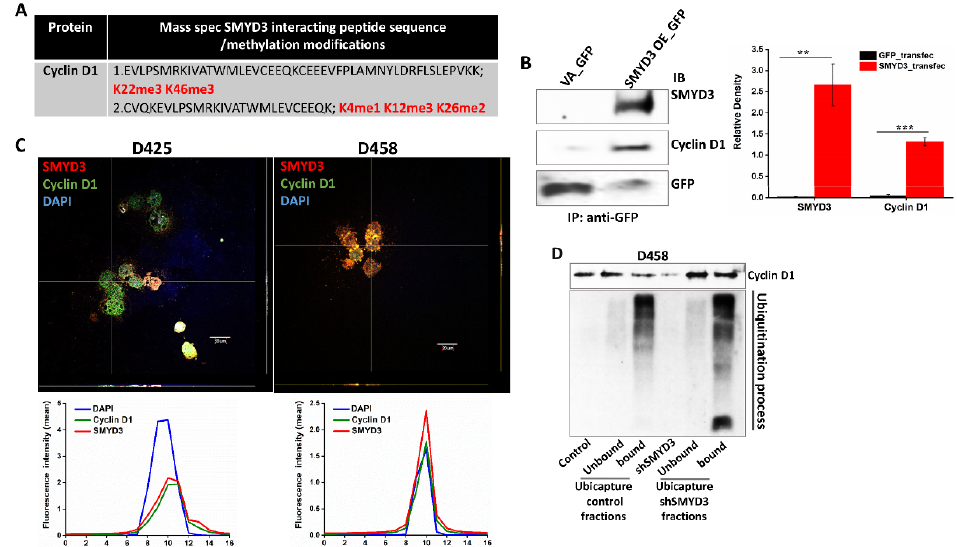
Figure 7. SMYD3-cyclin D1 interaction is associated with cyclin D1 stability in the nucleus. ( A ) LC/MS/MS analysis was performed using anti-SMYD3 antibody precipitated nuclear extracts of D283 cells. The mass spec analysis identified cyclin D1 peptide sequences and their lysine methylation modification sites. ( B ) D425 cell lysates (400 µg) from the GFP and GFP-tagged SMYD3 overexpressing cells were bound to the GFP-Trap ® Agarose beads (GFP Nanobody/single domain GFP monoclonal antibody domain coupled to agarose beads) for the IP of GFP-fused SMYD3 protein. The IPed proteins were then immunoblotted for GFP, SMYD3, and cyclin D1 proteins. The densitometry plot represents the ratio of the relative levels of SMYD3 or cyclin D1 to total GFP in each experimental condition. ( C ) Z-stack images (40× objective; 1-µm optical slice thickness) were captured using confocal microscopy (Olympus IX83) in MB cells to show the co-localization of SMYD3 (red) and cyclin D1 (green) proteins in the nucleus (DAPI). The fluorescence plot profiles in the lower panel confirmed that the two proteins, SMYD3, and cyclin D1 colocalize more in the nucleus ( D ) Ubiquitination assay on D458 control and shSMYD3 treated (48 h) cells. The cells were lysed and bound (40 µg) with a Ubicapture matrix to detect endogenous ubiquitinated cyclin D1 protein. The statistical significance ** p < 0.01, *** p < 0.001.